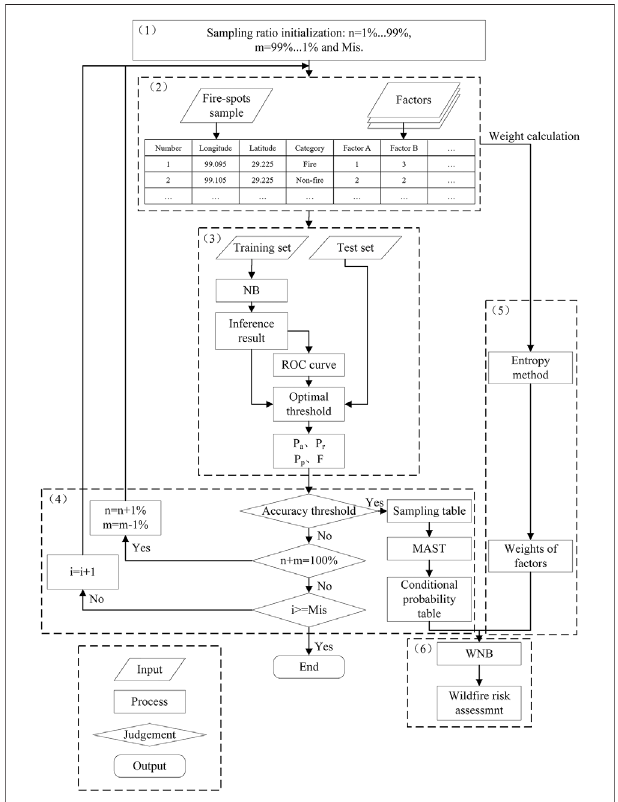
FIGURE 4 | The wild fi re risk assessment model framework on